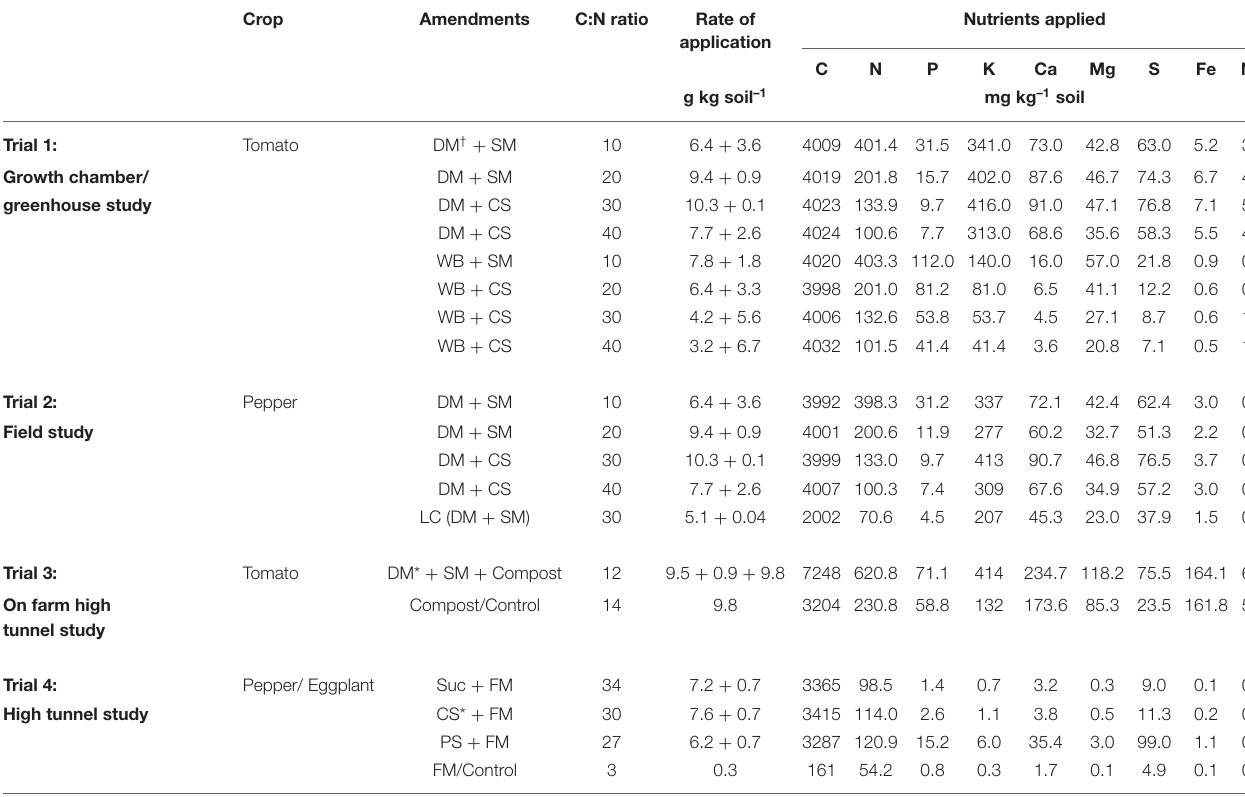
TABLE 1 | Amendment nutrient content and application rates in Trials 1, 2, 3, and 4.